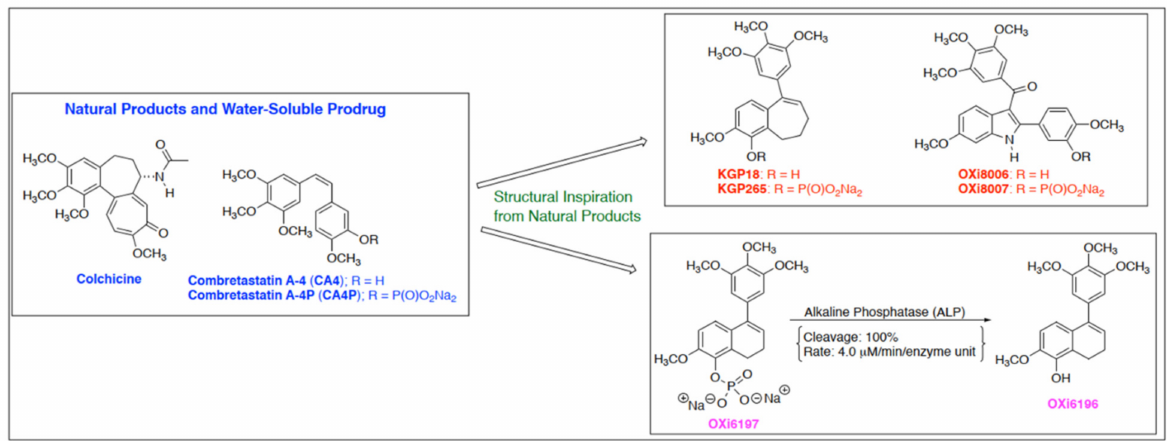
Figure 1. Molecular structures of OXi6196 and phosphate prodrug OXi6197, as well as related molecules exhibiting vascular disrupting activity. Exposure of prodrug OXi6197 to alkaline phos- phatase leads to rapid release of OXi6196